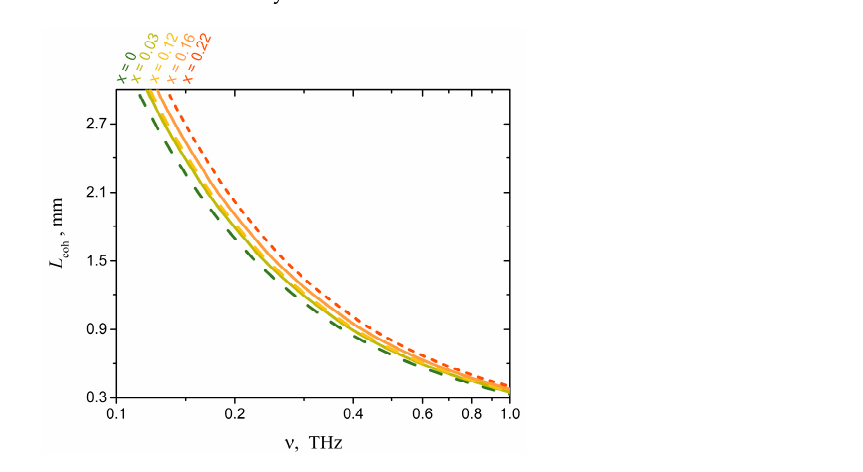
Figure 3. Coherence length L coh of the interaction of terahertz and laser radiation with a wavelength of λ = 1547 nm in GaSe:S crystals.